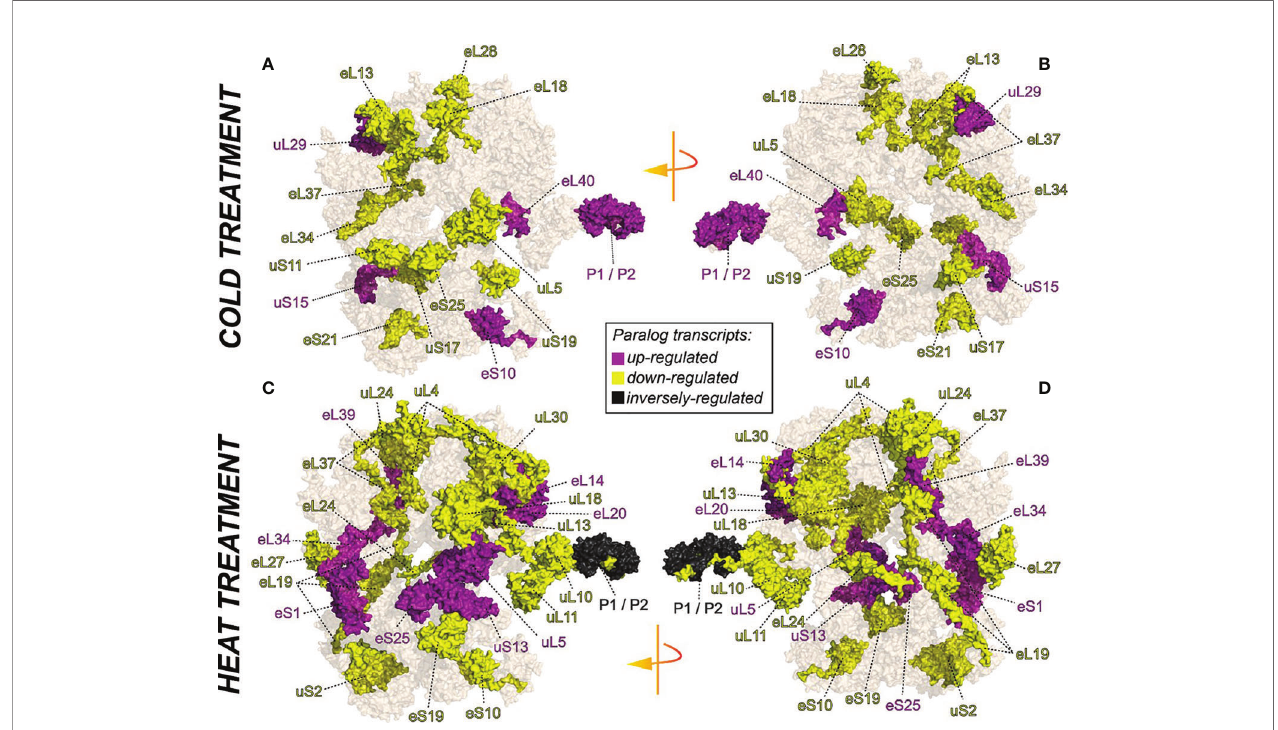
FIGURE 4 | RP remodeling potential of Arabidopsis 80S ribosomes upon 4°C cold stress (A , B) or 38°C heat stress (C , D) . The visualization outlines mapped changed transcript abundances in response to temperature stress compared to optimized control conditions, i.e., ~ 20°C. Transcript data were statistically evaluated across individual paralogs within RP families as reported in Figure 3 and mapped to a 3D rendering of the wheat 80S monosome (Armache, 2011) using the rotated 2D positions of Figure 2 . Homology of wheat and Arabidopsis RP families was con fi rmed by protein BLAST matching. Black color indicates RP families with inversely regulated paralog transcripts following either cold or heat stress. Yellow and purple represent RP families with increased or decreased transcript abundances of at least one of the RP paralogs. The paralog identities and temperature speci fi c transcript changes are reported in Supplemental Table S2